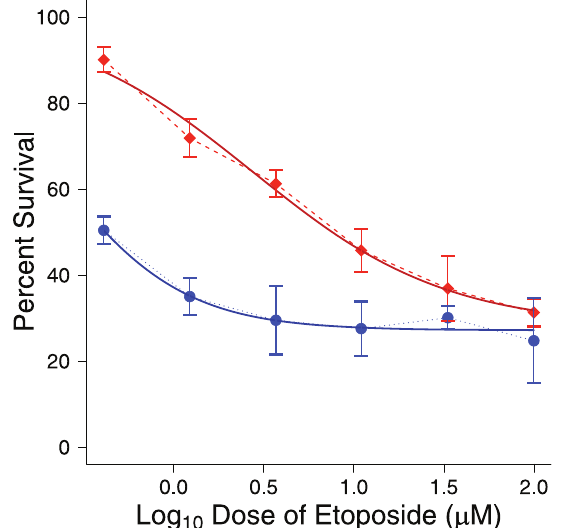
Figure 1. Cellular cytotoxicity assays determined that MCF7VP cells are more resistant to etoposide than the parental MCF7 cells. Curve fitting of cellular cytotoxicity data with GraphPad prism. (MCF7VP- red squares and MCF7- blue circles). The dotted line represents the actual curve and the solid line depicts the fitted curve. The assay was carried out using 10,000 cells per well of a 96 well plate and 100 m l of various concentrations (0–100 m M) of etoposide (the graph depicts log concentrations of